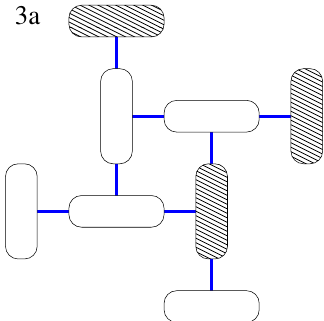
Figure 16: Three-triplon configurations of the local Hamiltonians